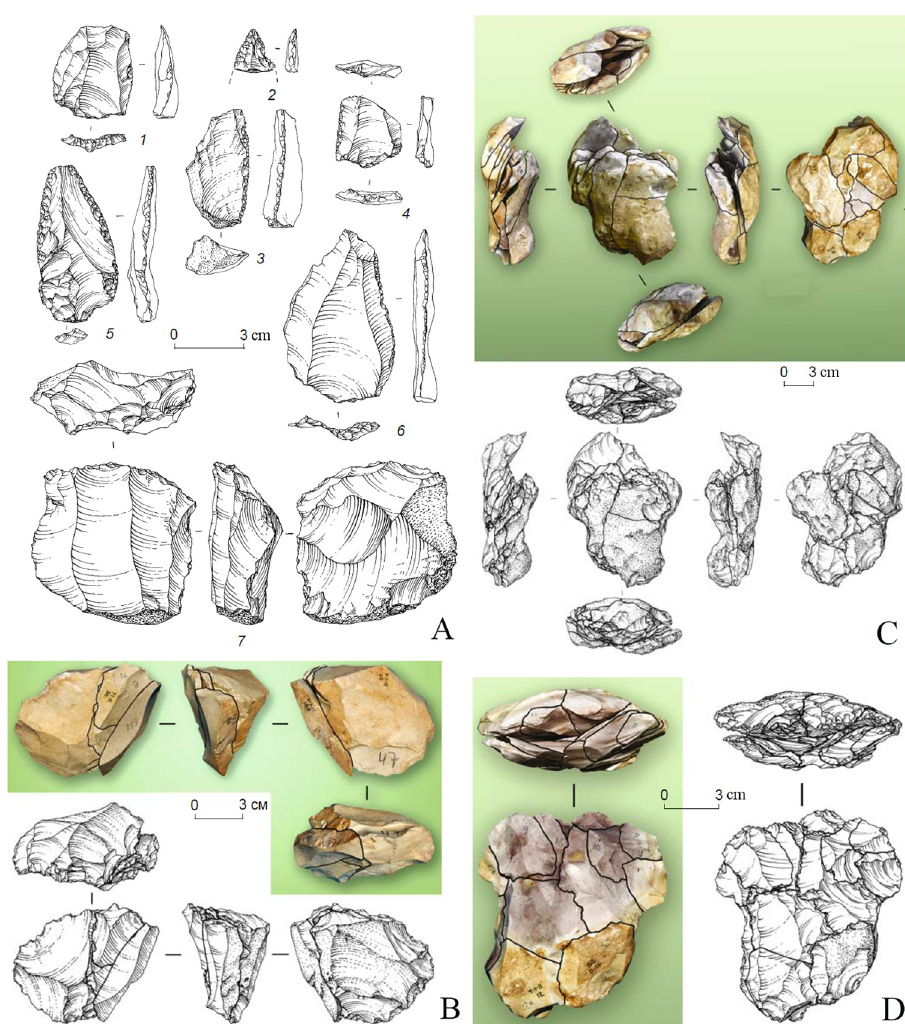
scrapers; 5 –elongated Mousterian point with a broken tip; 6 –Levallois triangular flake (point); 7 –Levallois recurrent core. B–D. Drawings and photos of three refitting samples, representing volumetric parallel flaking (B) and